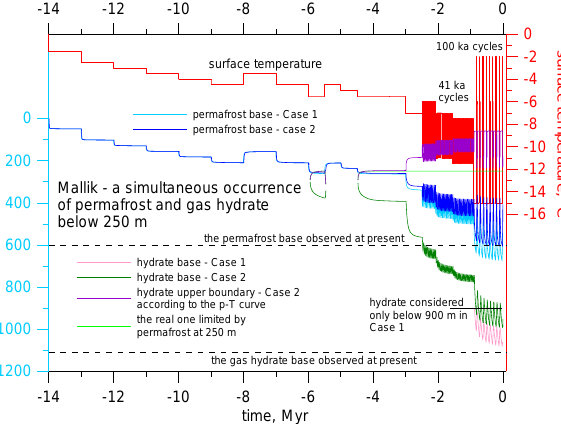
Fig. 8. A comparison of Case 1 and Case 2 results illustrating the respective depth variations of IBP and GH upper and lower boundaries during the last 14 Myr.